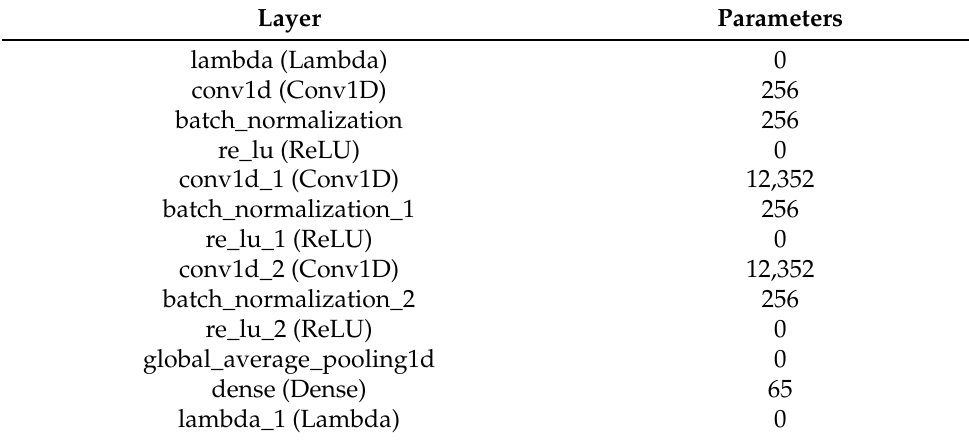
Table 3. Parameter breakdown per